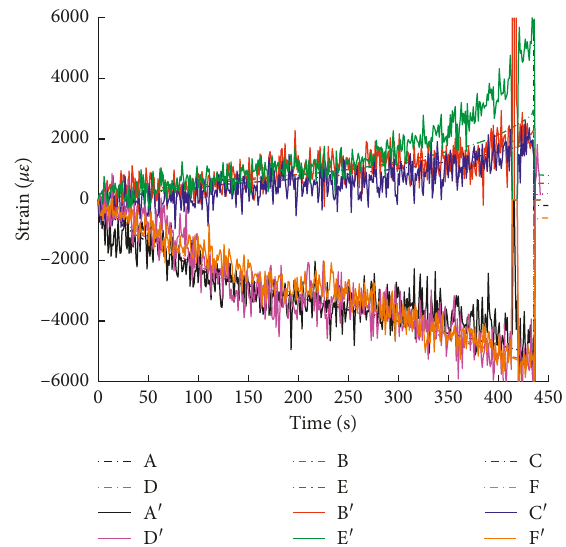
Figure 7: Comparison of strain values measured by strain gauges and DIC